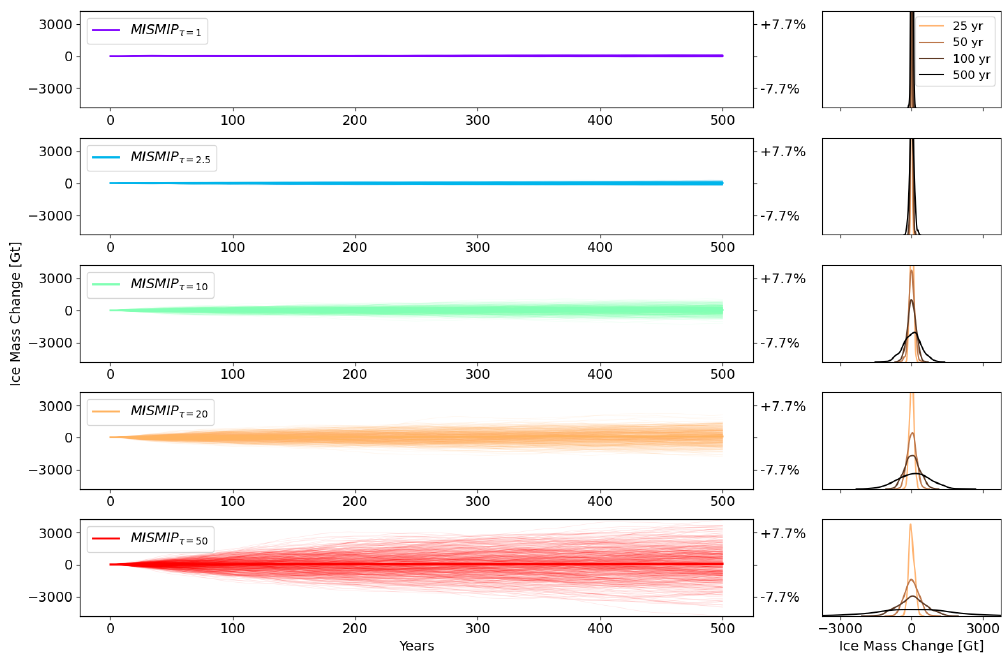
Figure 5. Left: change in ice mass throughout the transient experiments for each ensemble member in the five MISMIP+ transient ensembles. Thick lines show the ensemble means. The right y axis shows change relative to the initial ice mass. Right: corresponding PDFs of the ice mass change after 25, 50, 100, and 500 years of